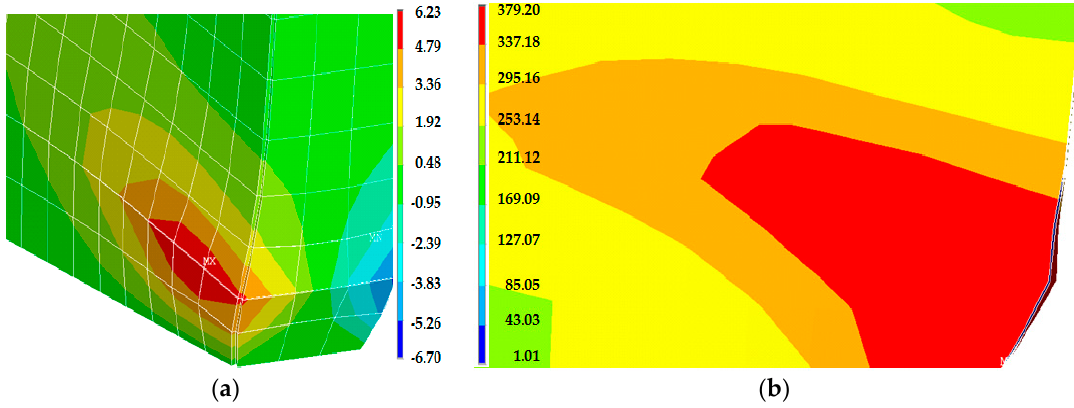
Figure 13. ( a ) Out-of-plane displacement (mm) of the analysed specimen SC4; ( b ) Failure mode of analysed specimen SC4—Distribution of Von Mises stresses (MPa) at the right toe of the wall.